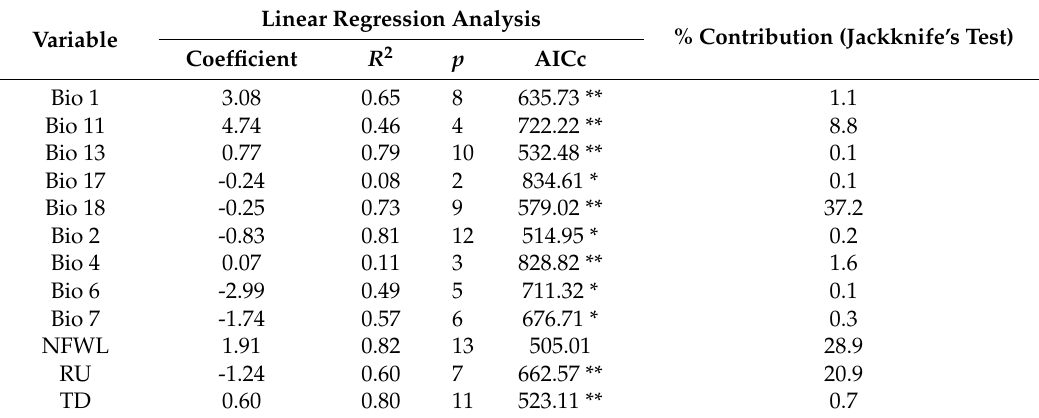
Table 4. Percent contribution of predicting variables on spatial distribution of WNV mosquito vector during 2015 in City of New Orleans, LA.